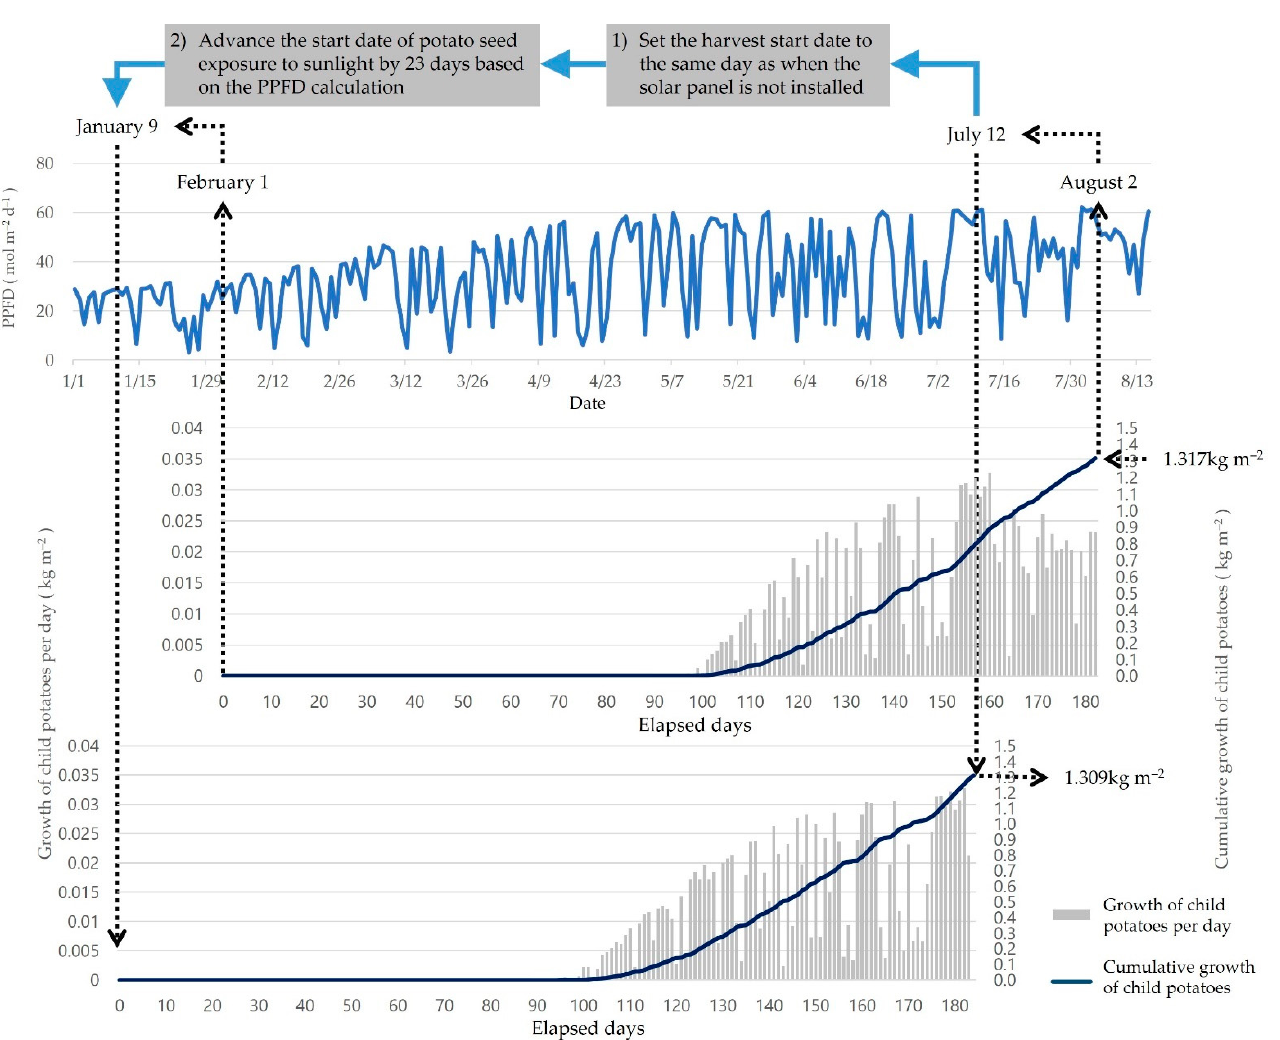
Figure 10. Calculation of cultivation date to avoid harvest date delays due to solar panel installation.